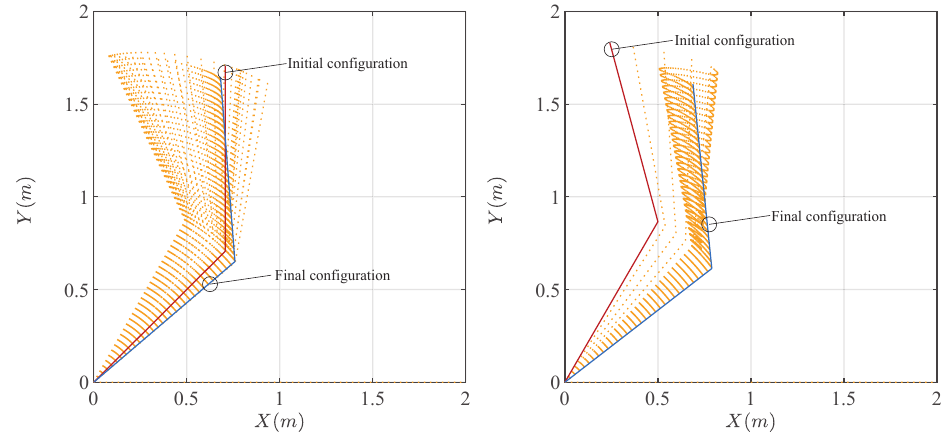
Figure 11. Task performances of the master and slave robots with the method in Case